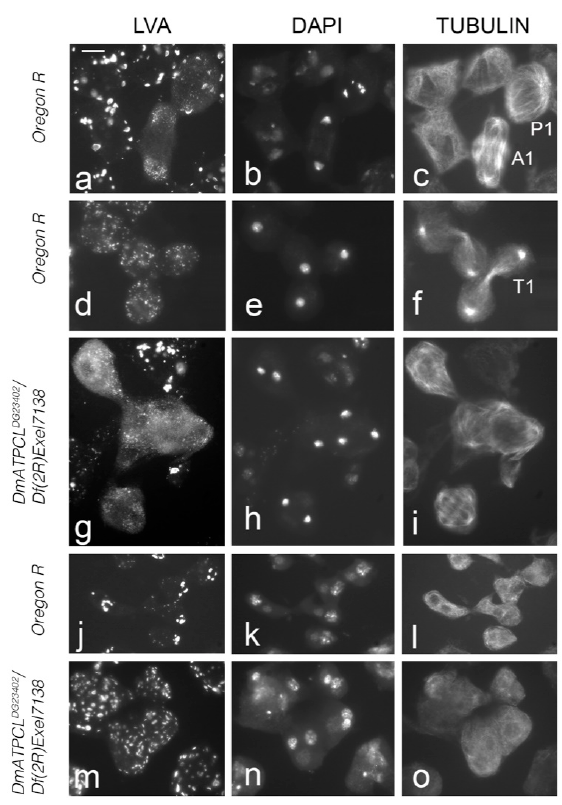
Figure 2. Loss of DmATPCL alters the organization, but not the segregation, of the Golgi structures, during male meiosis. The localization pattern of the Golgi in wild-type ( a – f , j – l ) and mutant ( g – i , m – o ) male meiotic divisions is similar. Note that DmATPCL mutant cell divisions are characterized by multipolar spindles, as previously described [8]. See text for the description of the Golgi localization pattern. Note that whereas in wild-type onion stage spermatids the Golgi form a well-defined struc- ture, the acroblast ( j – l ), in DmATPCL mutants, which also exhibit irregular nebenkern-nucleus associ- ations, the Golgi appear fragmented ( m – o ) leading to the loss of the acroblast. P1 = Prometaphase I; A1 = Anaphase I; T1 = Telophase I. Scale bar = 10 µ